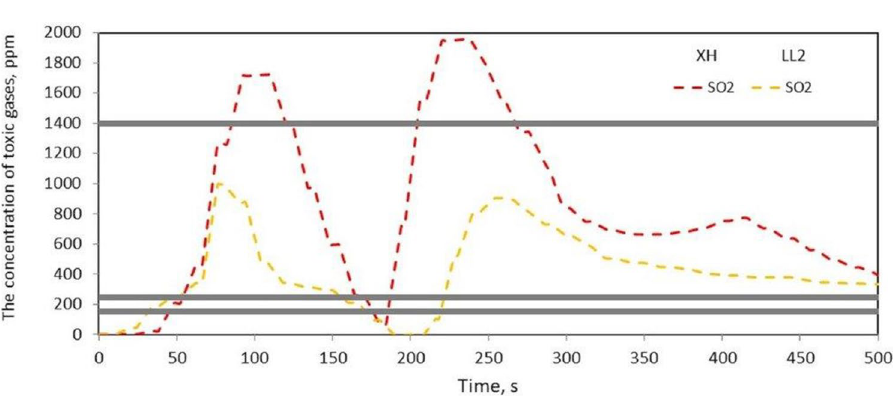
Figure 8. SO 2 concentration as a function of time during thermal decomposition and combustion of the tested belt samples with the indication of permissible values (Table